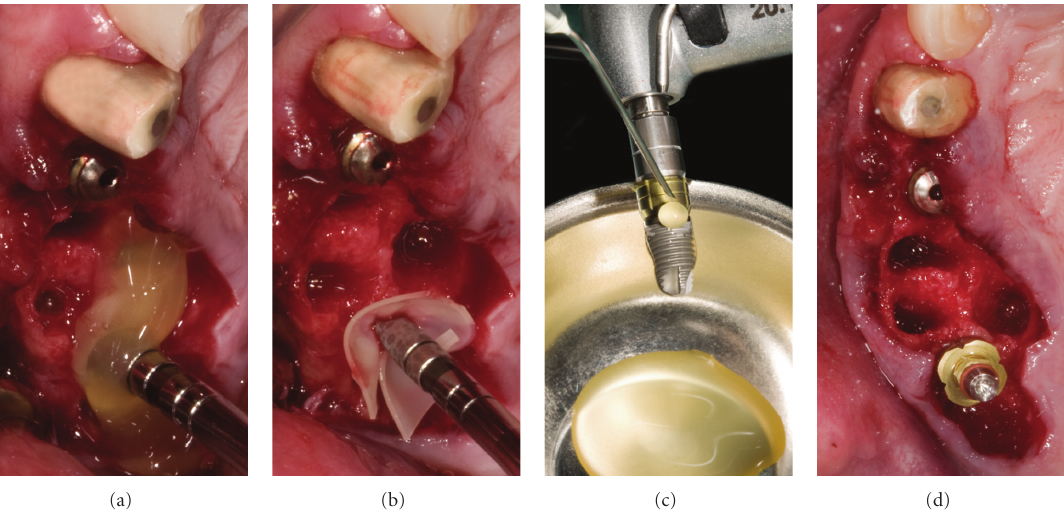
Figure 3: (a) Implant in site 1.5 was placed through standard protocol; a PRFG clot was positioned in the prepared socket before sinus floor elevation. (b) A membrane was placed apically in the so prepared site. (c) Before implant positioning, the fixture surface was bioactivated with liquid PRGF. (d) 2.5 and 2.7 implants in position.